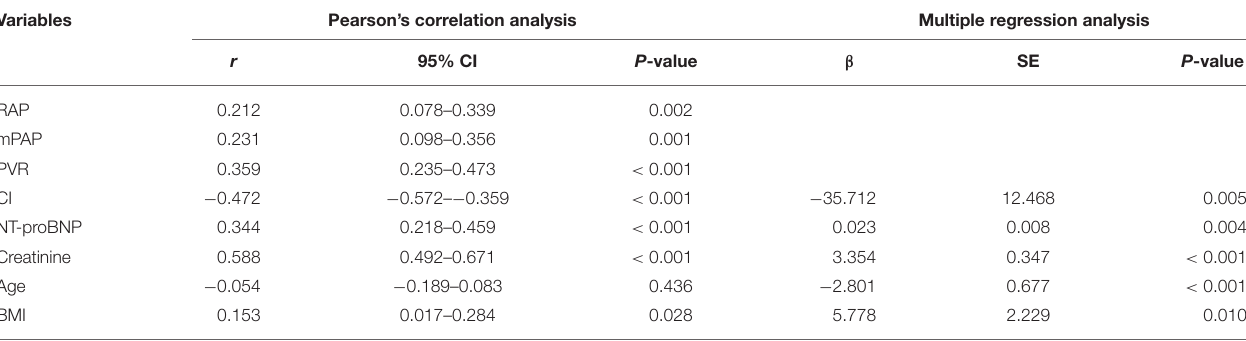
TABLE 2 | Analysis of variables associated with serum uric acid levels in patients with idiopathic pulmonary artery hypertension. Variables